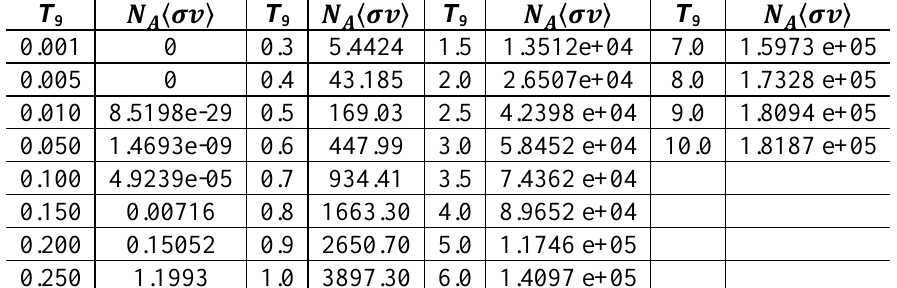
Table 2: Numerical values of reaction rate from BRUSLIB [10]. T are given in GK, and 〉 are in cm 3 mol -1 sec -1